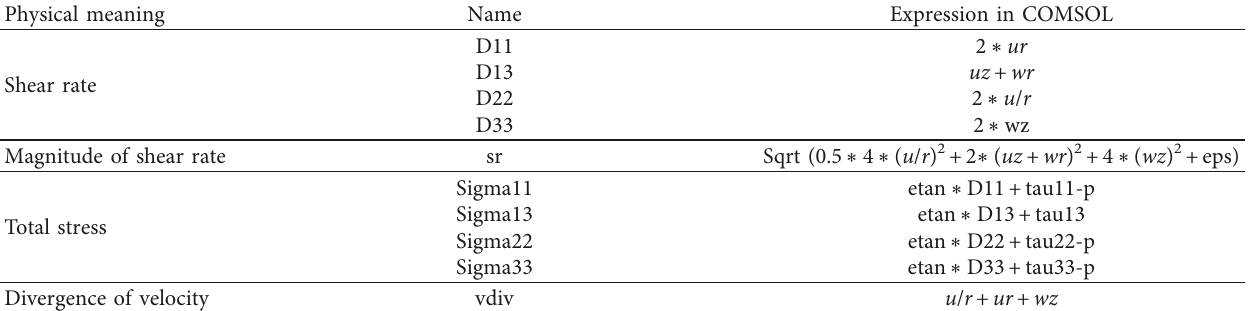
Table 1: Auxiliary variables defined in COMSOL for implementation